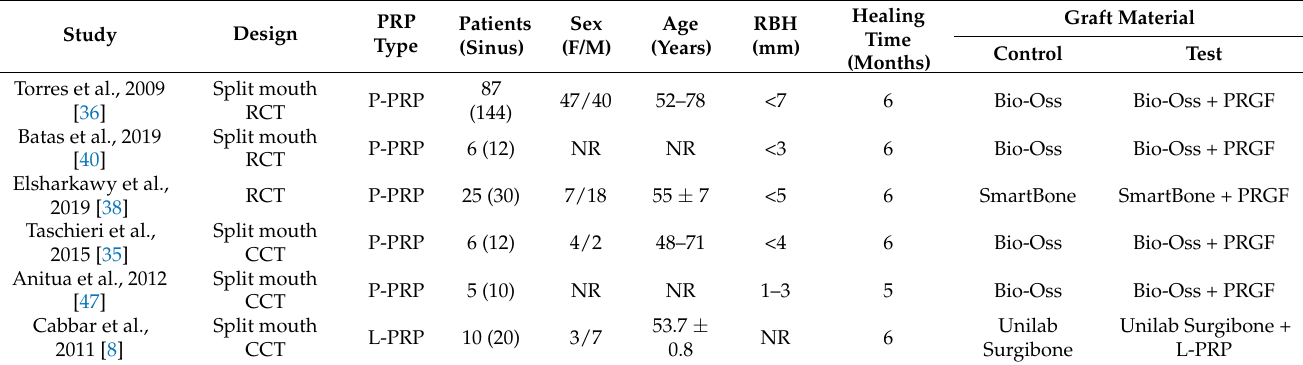
Table 1. Main characteristics of the included studies.